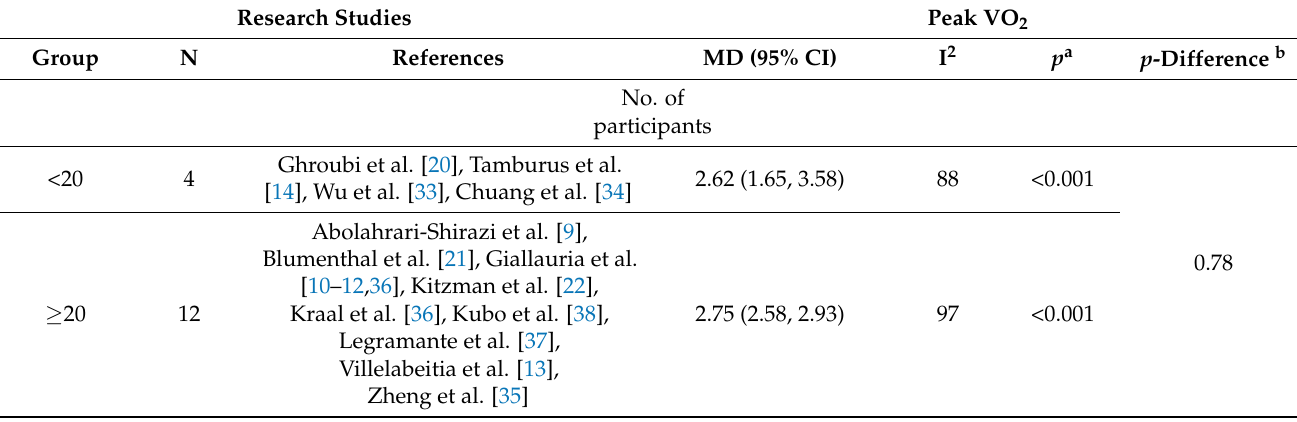
Table 2. Subgroup analyses assessing potential moderating factors for VO 2 peak increase in studies included in the meta-analysis by population